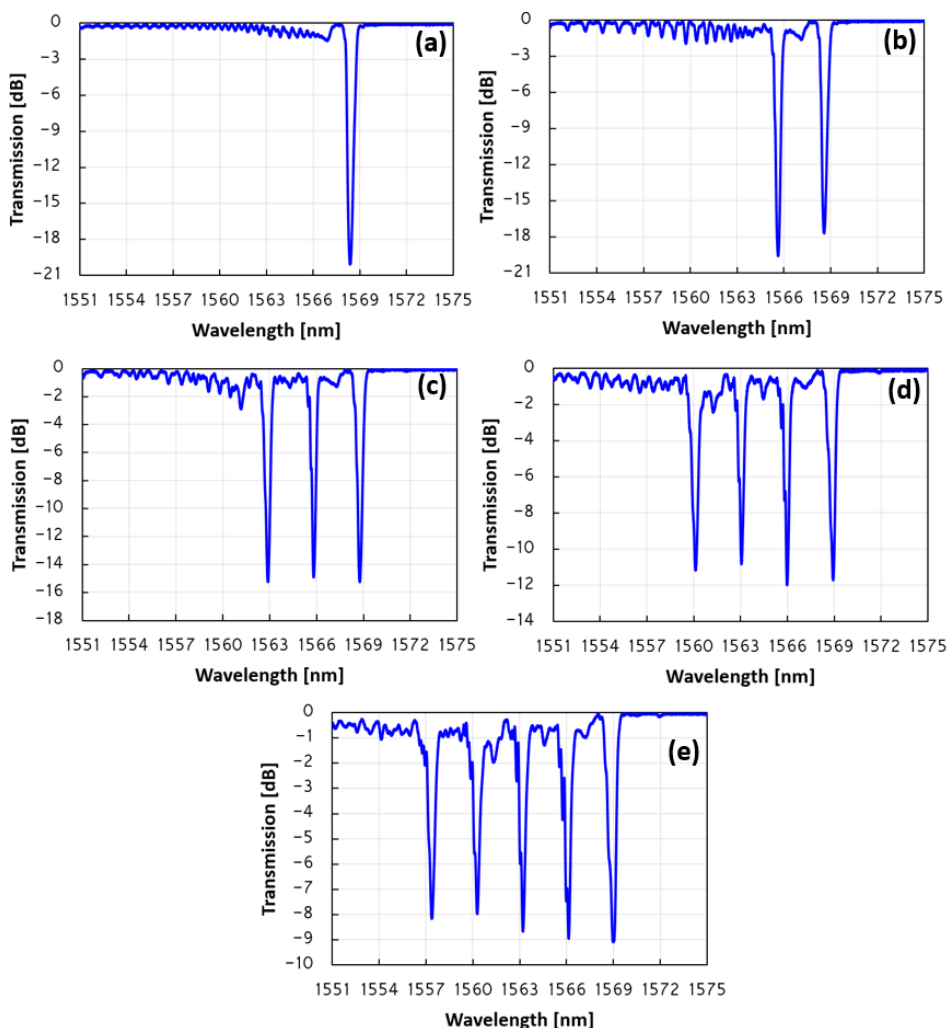
in Figure 3d. In addition, the transmission dips of all three FBGs are reduced from −15 dB to −12 dB and −11 dB, as can be seen in Figure 3e.